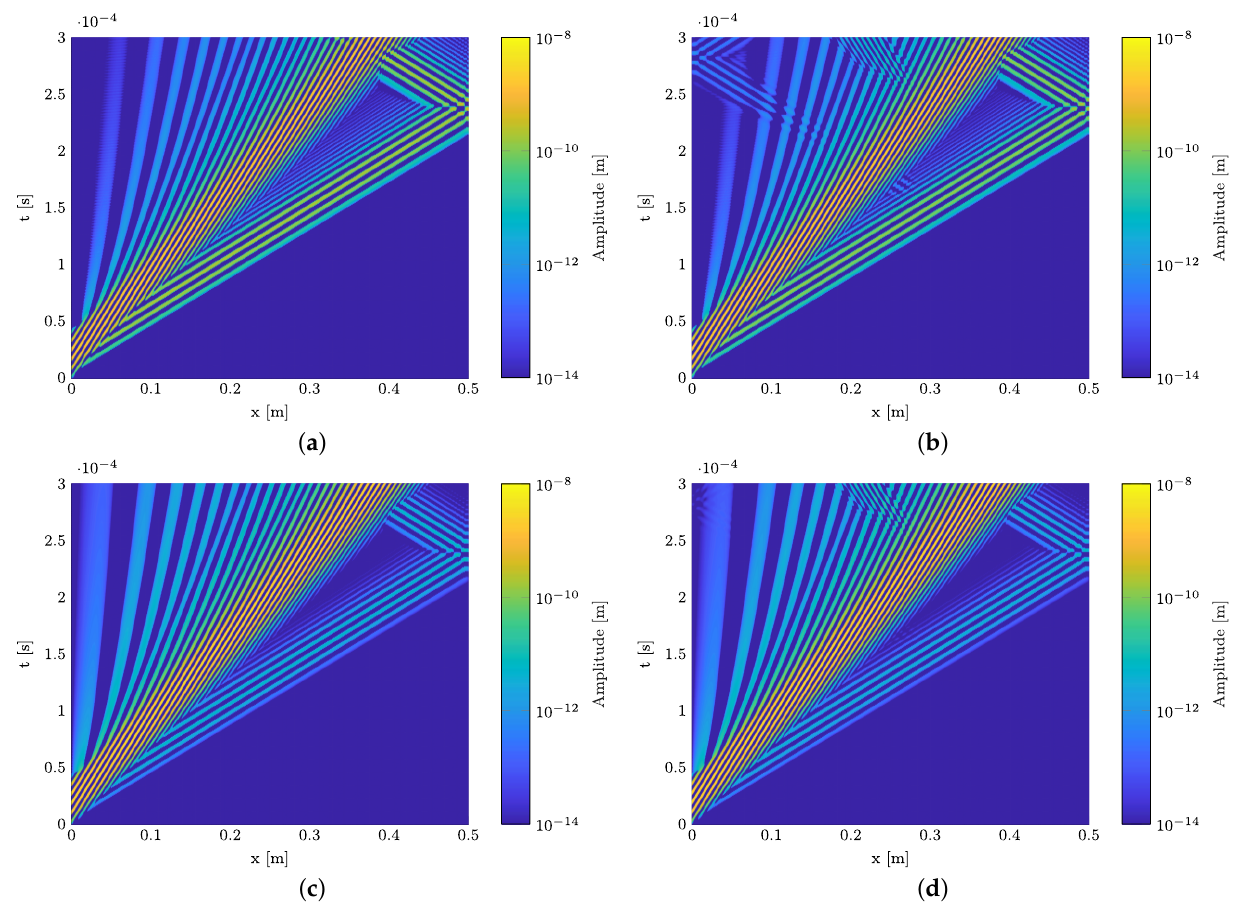
Figure 8. Comparison of the numerically determined wave propagation in a pure GFRP laminate and a waveguide including a polyimide inlay in the midplane at a burst center frequency of 120kHz using a B-scan representation. The polyimide inlay starts at 0.3m (cf. Figure 5). ( a ) Wave field without polyimide inlay, in-plane displacement field. ( b ) Wave field with polyimide inlay, in-plane displacement field. ( c ) Wave field without polyimide inlay, out-of-plane displacement field. ( d ) Wave field with polyimide inlay, out-of-plane displacement